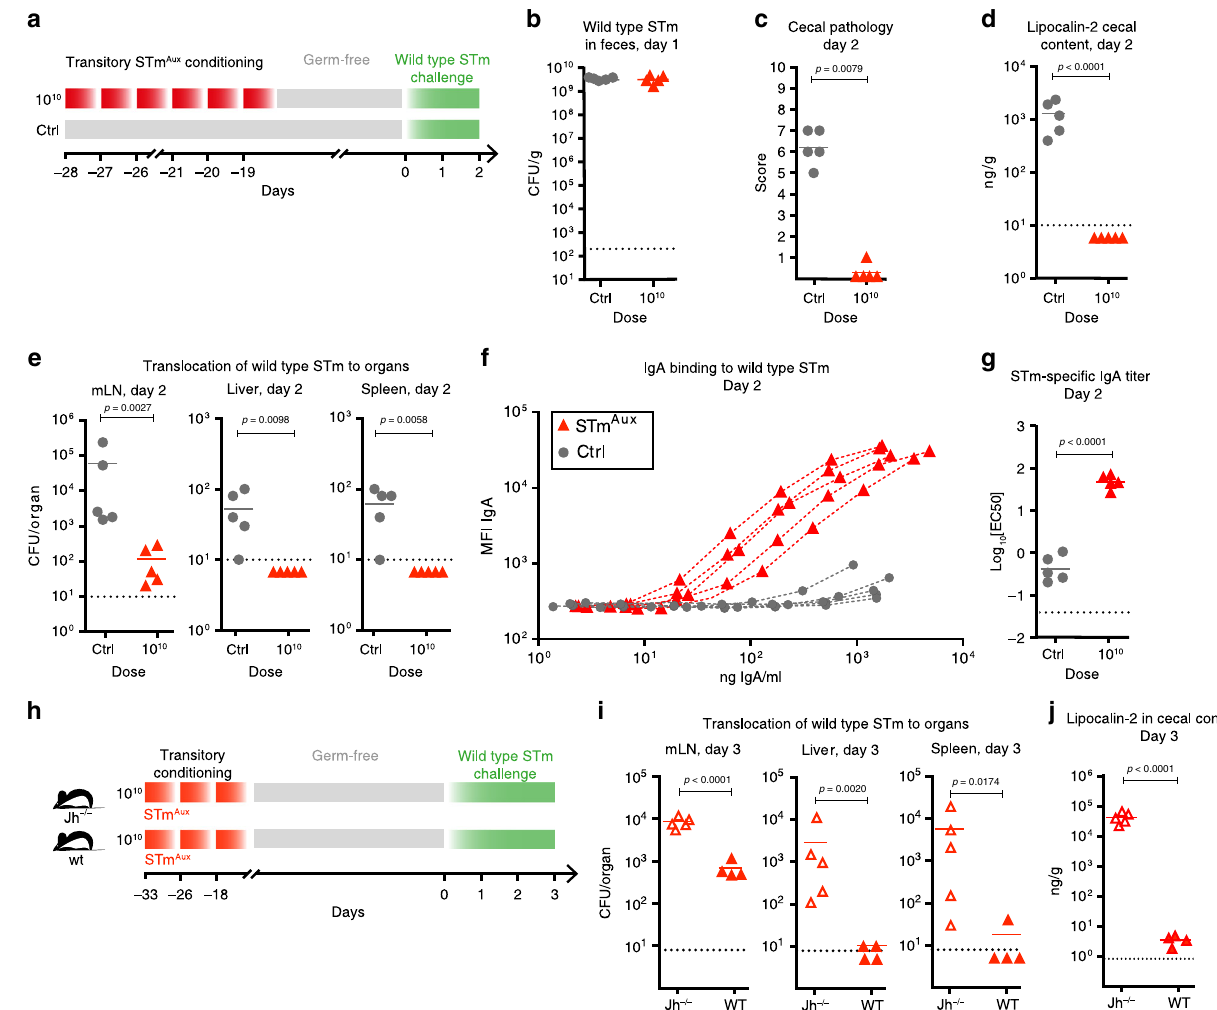
Fig. 2 Intestinal conditioning of GF mice with STm Aux induces B cell dependent functional intestinal immunity. a Germ-free mice were enterally conditioned with six doses of 10 10 CFU of STm Aux (red triangles, n = 5 animals) or were left untreated (gray- fi lled circles, n = 5 animals). Four weeks after the fi rst treatment (day 0) mice were challenged with wild-type STm (10 5 CFU) and analyzed 2 days later. Each symbol represents one individual. b Shedding of wild-type STm in feces 1 day after challenge. c Cecal histopathology score at day 2 after challenge. Each symbol represents one individual. d Lipocalin-2 concentration in cecal contents at day 2 after challenge. e Bacterial burden of wild-type STm in mLNs, spleens, and livers at day 2 after challenge. f Intestinal secretory IgA was isolated at day 2 after challenge. IgA binding to wild-type Salmonella was quanti fi ed at different antibody concentrations by live bacterial fl ow cytometry. Connected symbols represent one individual. g STm-speci fi c titer ( − logEC 50 ) calculated from the STm-IgA titration curve plotted in Fig. S4J. h Experimental design: Germ-free Jh − / − (open symbols, n = 5 animals) and wild-type control mice ( fi lled symbols, n = 4 animals) were enterally conditioned three times with 10 10 CFU of live STm Aux . Thirty-three days after the fi rst treatment (day 0) all mice were